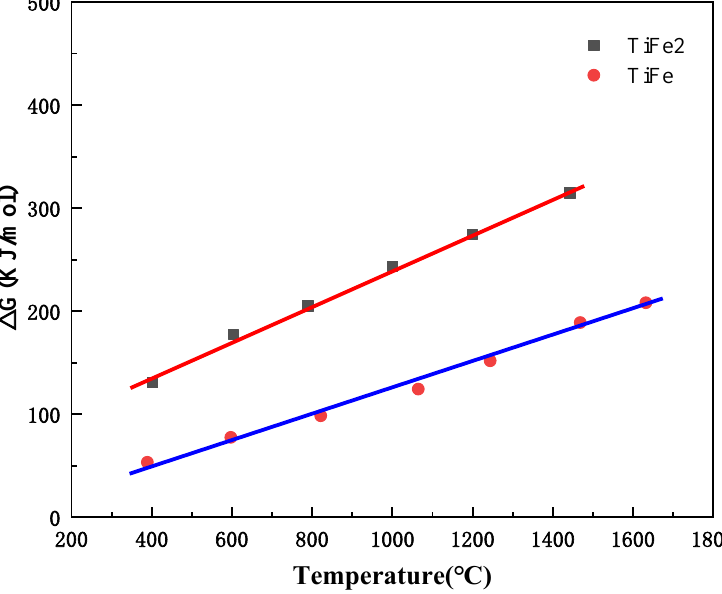
Figure 6. Temperature—Gibbs free energy curve of TiFe and TiFe 2 . Figure 7 showed the formation process of reaction layer in the welding